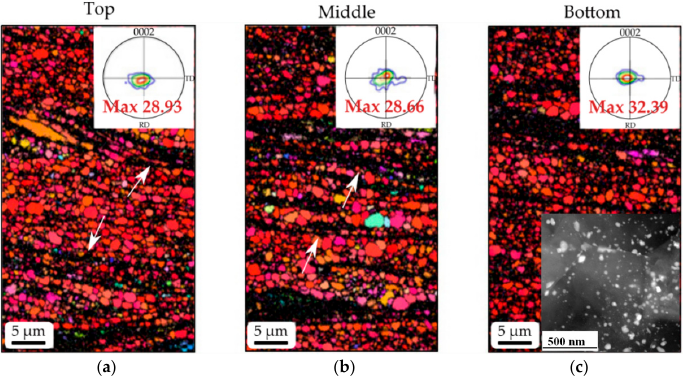
Figure 16. EBSD of the ( a ) top, ( b ) bottom and ( c ) middle of the HRDSRed ZK60 alloy, showing uniform microstructure and texture with narrow shear bands (white arrows) [83]. The inset in ( c ) shows the dispersion of fine Mg 2 Zn particles in the matrix. Reproduced with permission from Kim et al., Scr. Mater. ; published by Elsevier, 2010. Figure 17a–d show the microstructure of as-cast Mg–9.25Zn–1.66Y alloy and the deformed microstructures after ESR and HRDSR with SRs of 2 and 3. In the cast microstructure, the eutectic phase with lamellar structure composed of icosahedral ( I ) phase and α -Mg phases is almost continuous along the grain boundaries. During ESR, the eutectic structure was refined to some extent, but its continuous network structure remained integrated. However, the eutectic structure was fragmented intensively during the HRDSR process. The eutectic network structure was destroyed, and the broken pieces were aligned to the rolling direction. The eutectic I -phase structure was more effectively broken into a lot of smaller particles and the broken pieces were more uniformly dispersed into the matrix when a higher SR was applied. The above two results demonstrate the capability of HRDSR in crushing and dispersing the secondary phases, as well as grain refining.